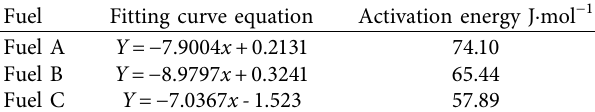
Table 3: Activation energy of particles. Fuel Fitting curve